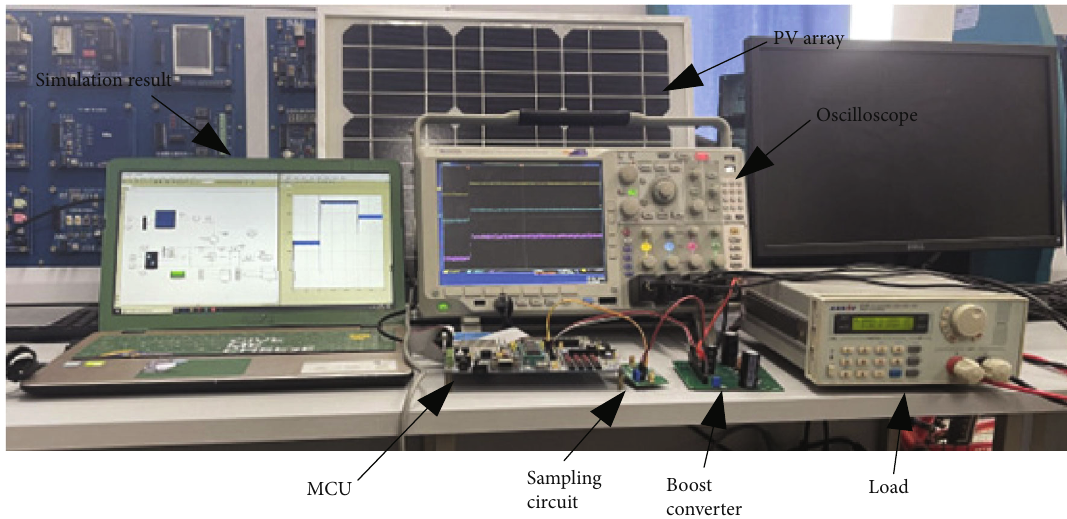
Figure 20: Experimental system with MPPT.